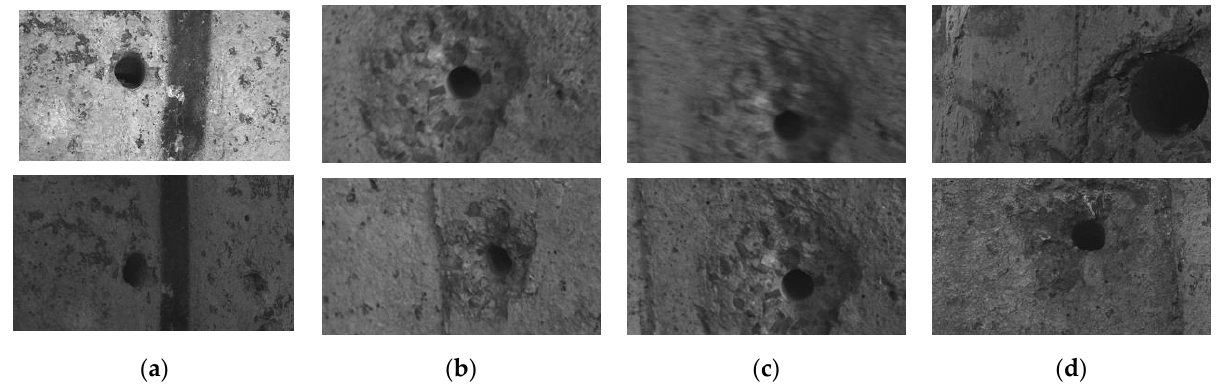
Figure 9. Pressure relief hole images under different conditions: ( a ) different brightnesses; ( b ) different shooting angles; ( c ) different blurring degrees; ( d ) different shooting distances.